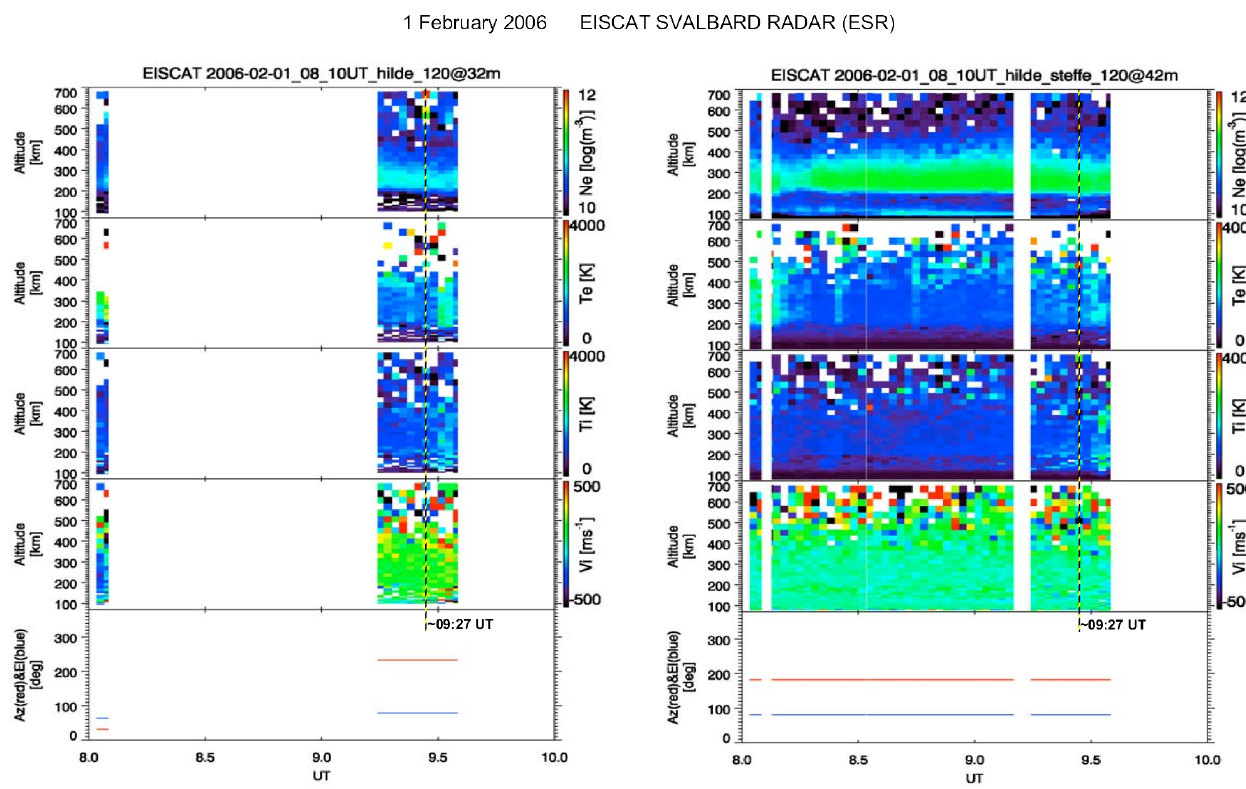
Fig. 5. Standard analysis of the ESR data from the 32m antenna (left) and the 42m antenna (right) where the panels show from the top to the bottom: the electron density, the electron temperature, the ion temperature and the ion drift velocity. The integration time is 120s and the black/yellow line corresponds to the time that REIMEI passes the 32m antenna